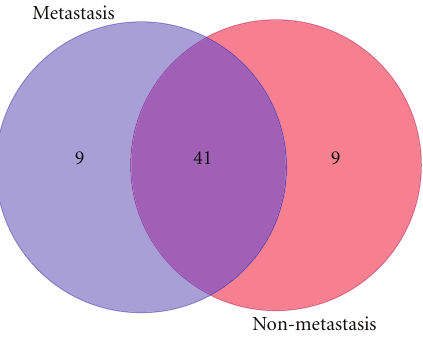
Figure 9: Venn diagram of top 50